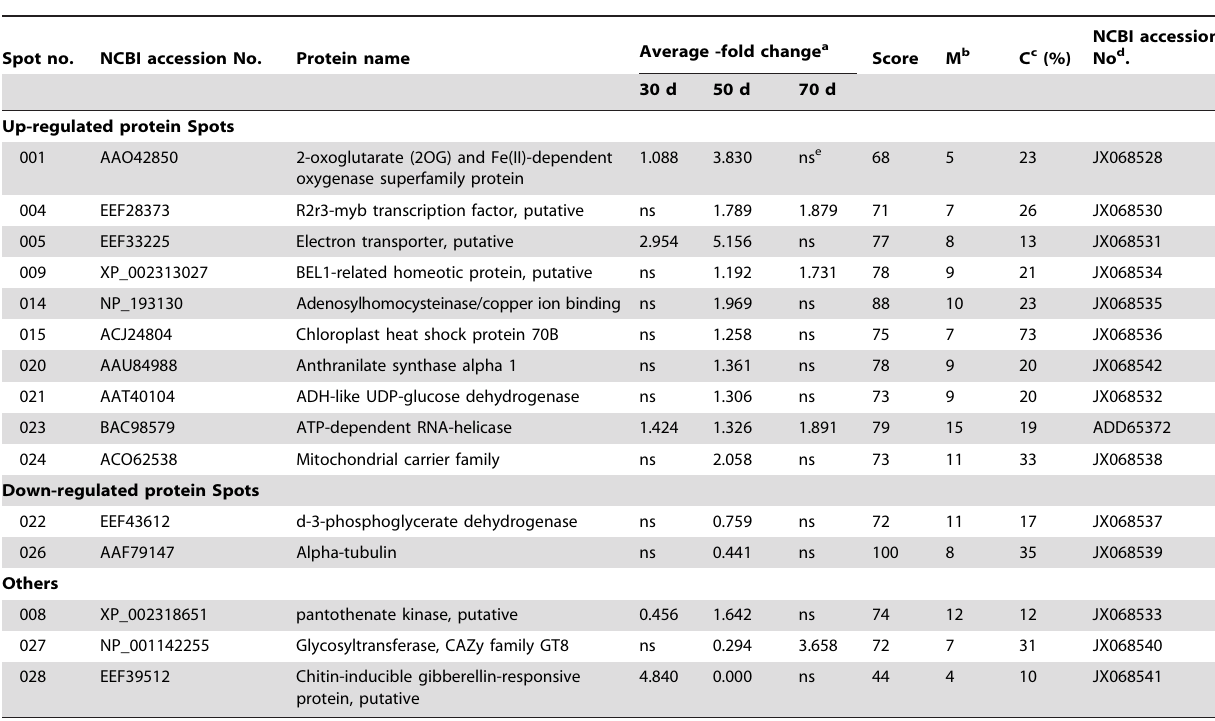
Table 1. Differentially expressed proteins which have S. baicalensis cDNA sequence.